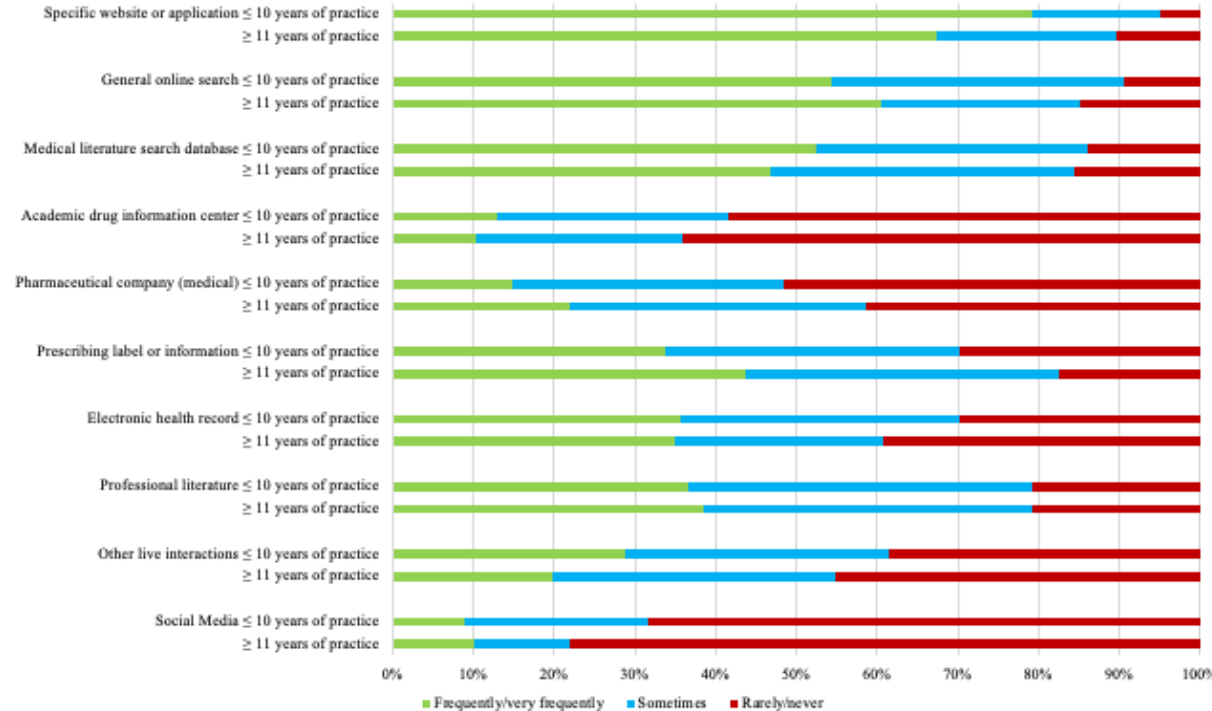
Figure 4. Search option preference based on years of